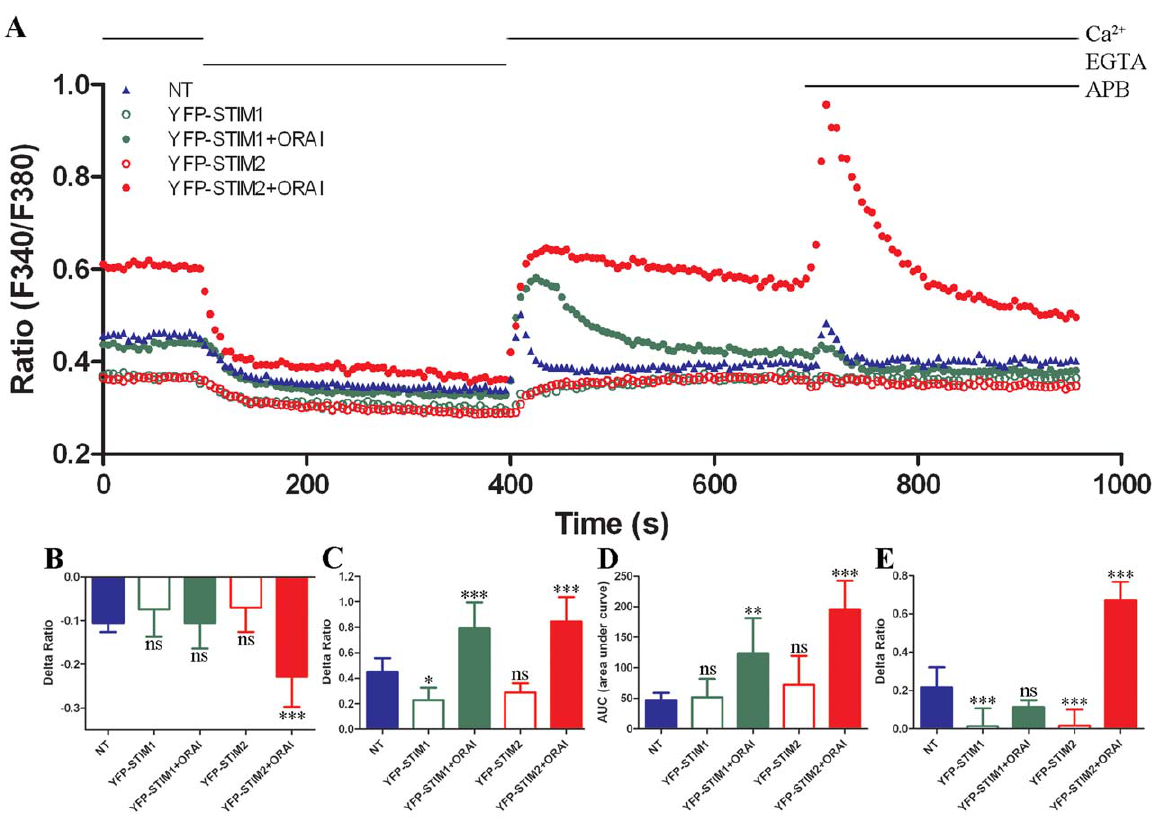
Figure 6. Analysis of spontaneous store repletion in transfected neurons. ( A ) Cytosolic Ca 2 + measurements were performed in cells overexpressing YFP-STIM1 6 ORAI1 or YFP-STIM2 6 ORAI1 or in nontransfected (NT) cells. The experiments started in the presence of 2 mM CaCl 2 , followed by transfer to Ca 2 + -free medium. A buffer was then supplemented with 2 mM CaCl 2 for 5 min to monitor intracellular Ca 2 + restoration. Finally, 50 m M 2-APB was added. Raw (not normalized) traces are shown, which represent the average of at least 30–50 cells from two independent experiments. ( B ) Summary of basal Ca 2 + at the beginning of the experiment. Data are shown as the Delta Ratio values, which were calculated as the difference between the F 340 /F 380 ratio after extracellular Ca 2 + was removed and its maximum level at the beginning of the experiment. ( C–D ) Analysis of constitutive calcium entry in transfected cortical neurons. Traces were normalized to 1 and are shown as a Supplementary Material (Figure S2A). ( C ) The average increases in Ca 2 + entry (peak Ca 2 + rise) observed after the addition of 2 mM CaCl 2 to transfected cells compared with nontransfected cells are shown. ( D ) Statistical evaluation of the integrated Ca 2 + responses (area under the curve [AUC]) is shown. ( E ) Effect of 2-APB on Ca 2 + responses (peak Ca 2 + rise). Traces normalized to 1 are shown as Supplementary Material (Figure S2B). The average Ca 2 + responses to 50 m M 2-APB in 2 mM Ca 2 + in cells transfected or nontransfected are shown. ( B–E ) * p , 0.05, *** p , 0.001, compared with control; ns, not significant (ANOVA). Bars indicate mean 6 SD from at least 30–50 cells measured in two independent experiments.